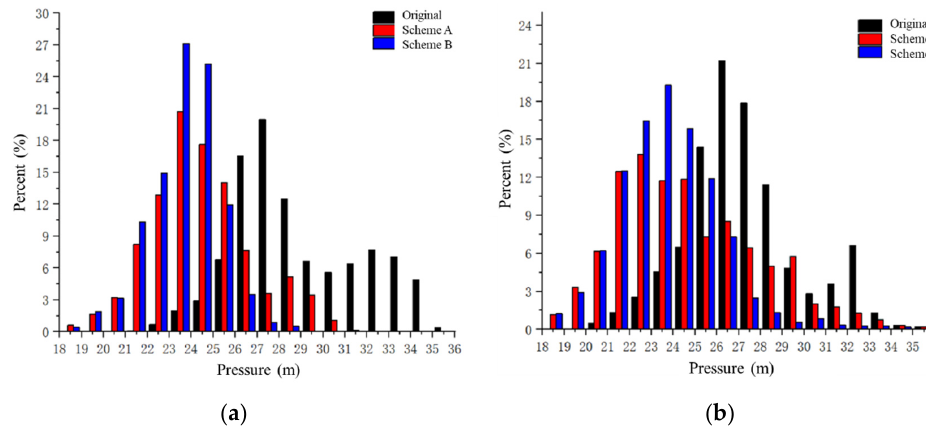
Figure 6. Pressure distribution: ( a ) valley demand period; ( b ) Peak demand period.